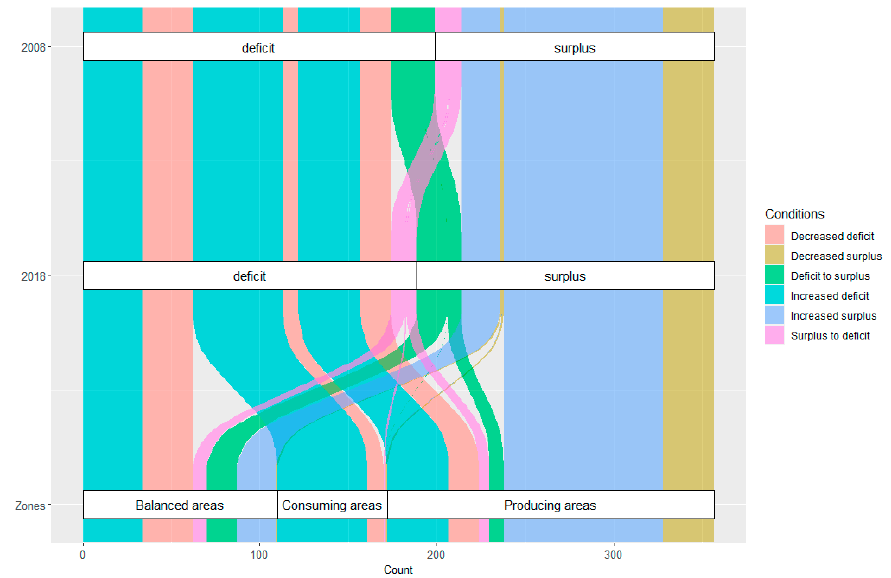
Figure 6. The proportion of cities with different types of grain insecurity in the producing, consuming, and balanced areas. The vertical axis indicates the period from 2008 to 2018 and the horizontal axis indicates the number of cities.